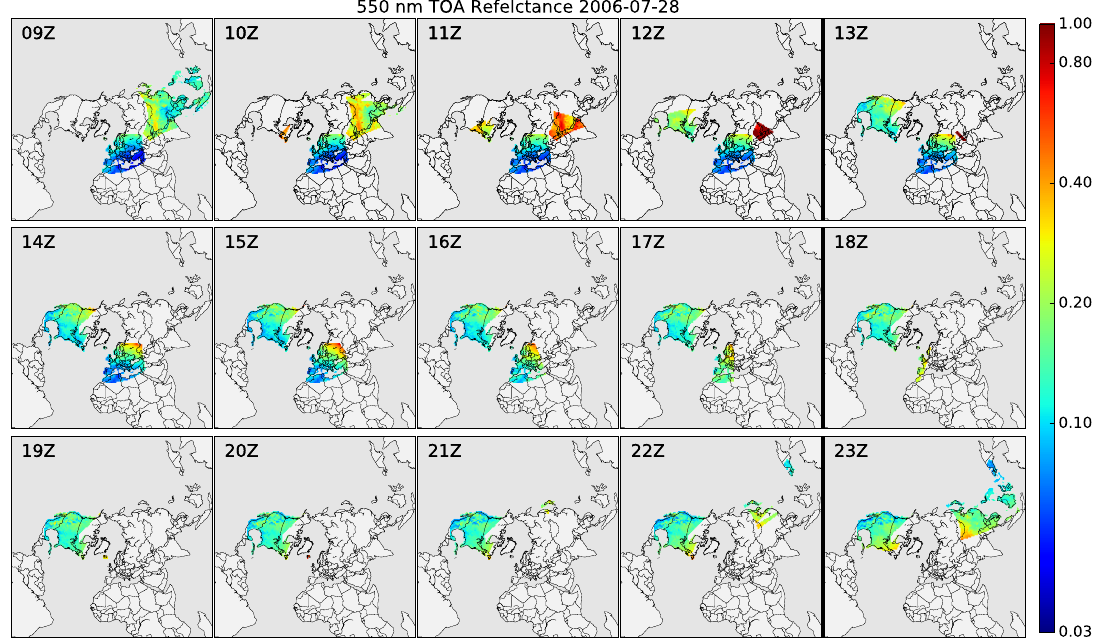
Figure 9. Simulated 550 nm TOA reflectance as would be observed by the geostationary constellation over 15 h on 28 July 2006.